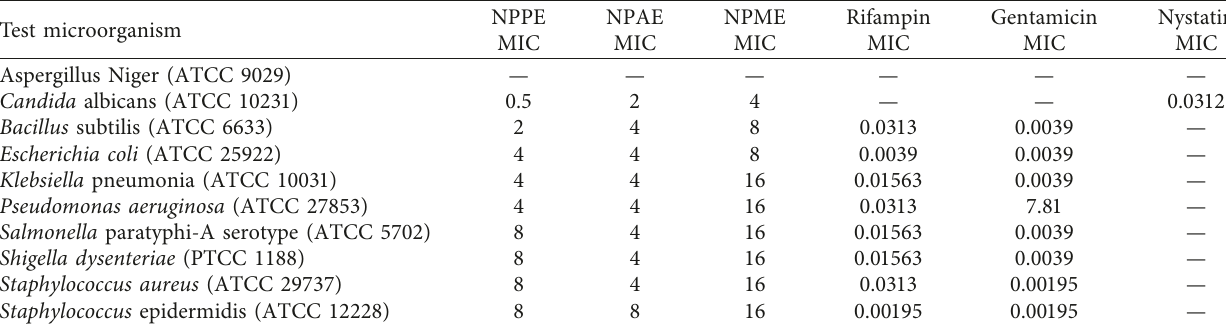
Table 5: Antimicrobial and antifungal (MIC) results of extracts and commercial antibiotics. Test